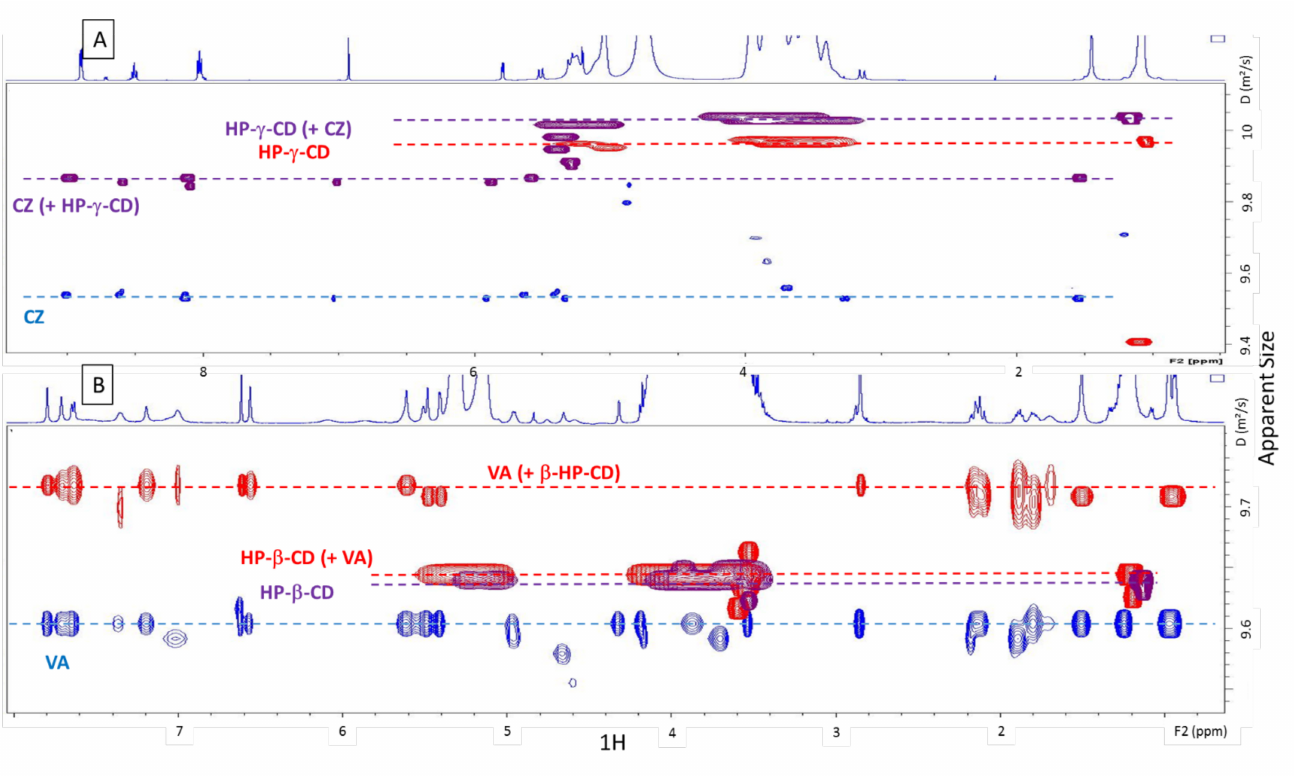
Figure 3. The 1 H-diffusion ordered spectroscopy spectra of ( A ) ceftazidime (CZ, blue curve), hydroxypropyl- γ -cyclodextrins (HP γ CD, red curve) alone and in mixture at 50 mg ml − 1 and at pH 4 (purple curve) and ( B ) of vancomycin (VA, blue curve), hydroxypropyl- β -cyclodextrins (HP β CD, purple curve) alone and in mixture at 50 mg/mL and at pH 3 (red